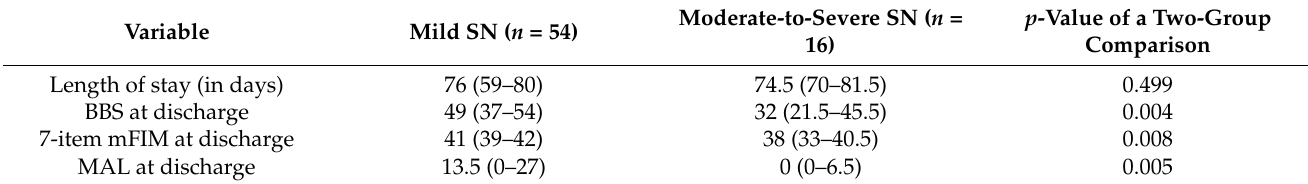
Table 5. Outcomes of patients with